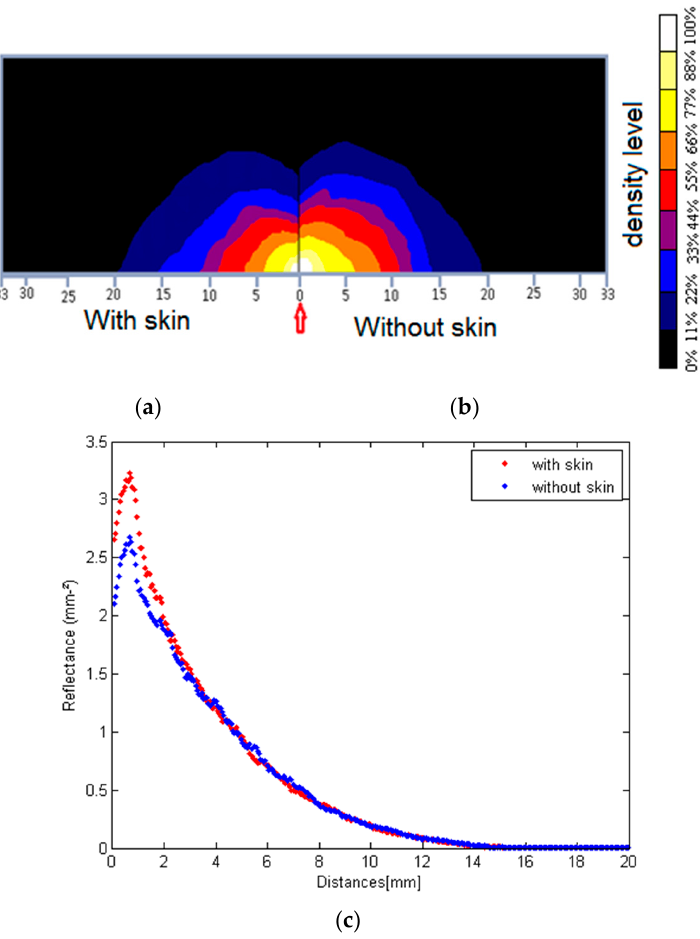
Figure 6. Backscattering images acquired over the cut equatorial plane of a Granny Smith illuminated by a light source located at z = − 3 mm, and emitting at 633 nm. ( a ) Apple with skin; ( b ) apple without skin; and ( c ) extracted reflectance profiles from the backscattering images.